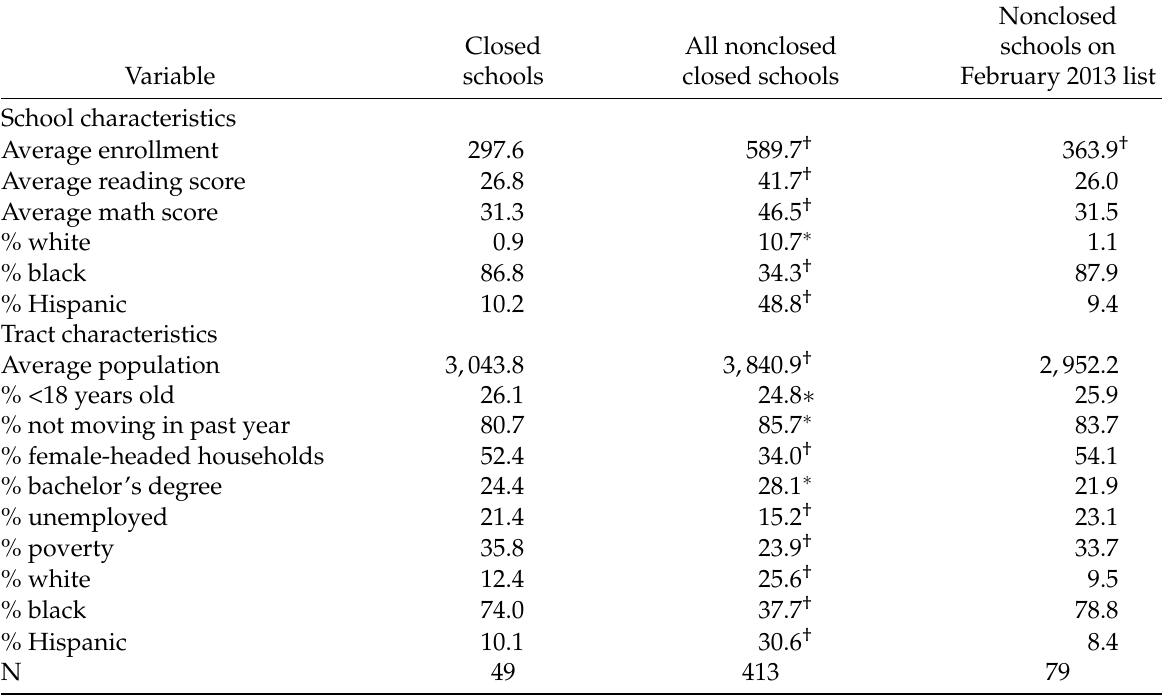
Table 1: Mean characteristics of Chicago public elementary schools and their tracts by 2013 closure